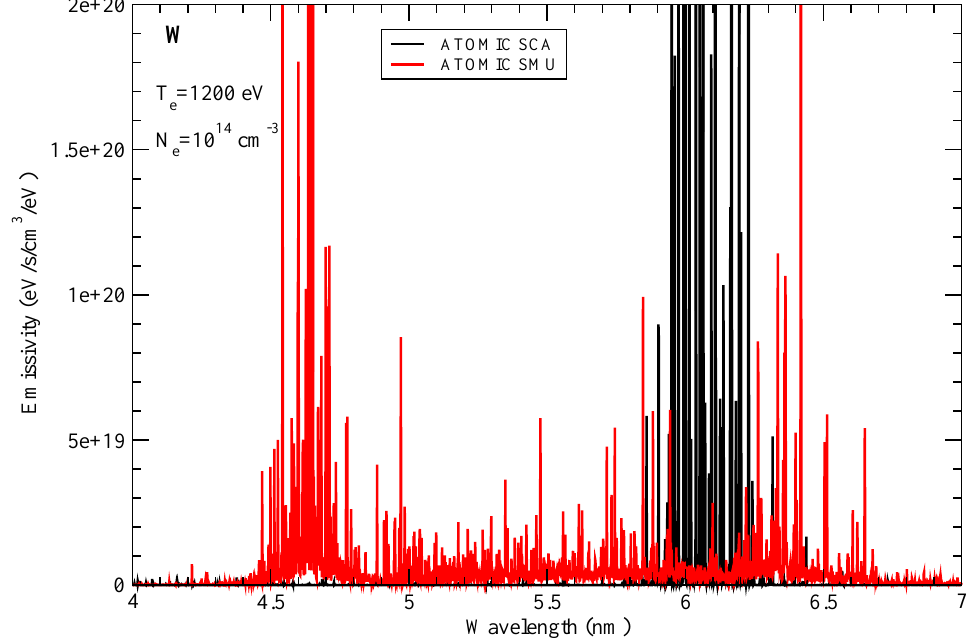
Figure 4. Same as Figure 3, except at an electron temperature of 1200 eV, and that we do not present an ATOMIC SCA UTA